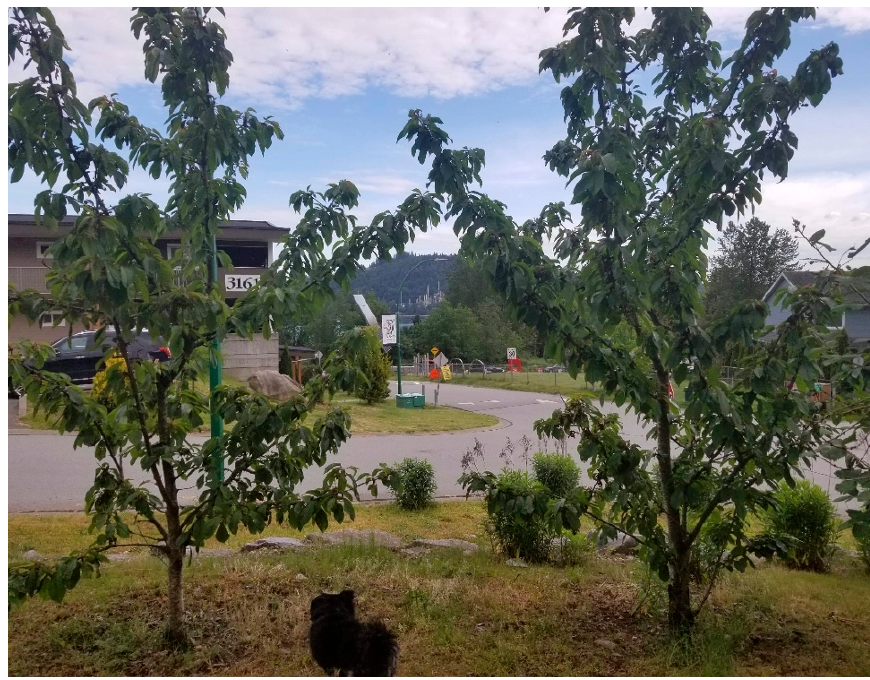
Figure 7. (Photo Credit: Jiovanni Beltran).